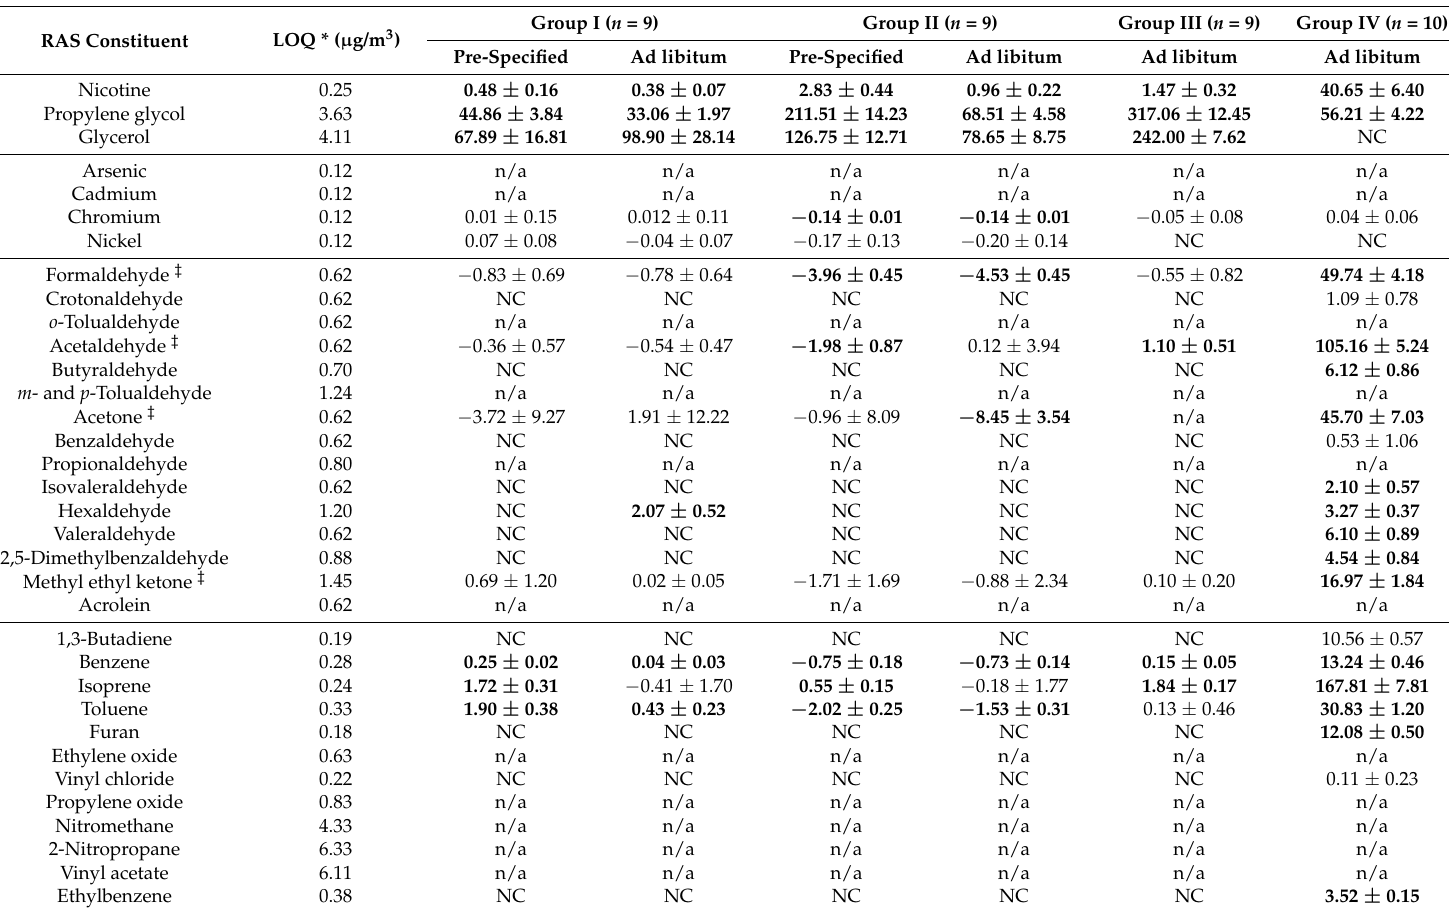
Table 1. Mean changes in the level of nicotine, PG, glycerol and selected constituents in RAS from baseline to product use conditions ( µ g/m 3